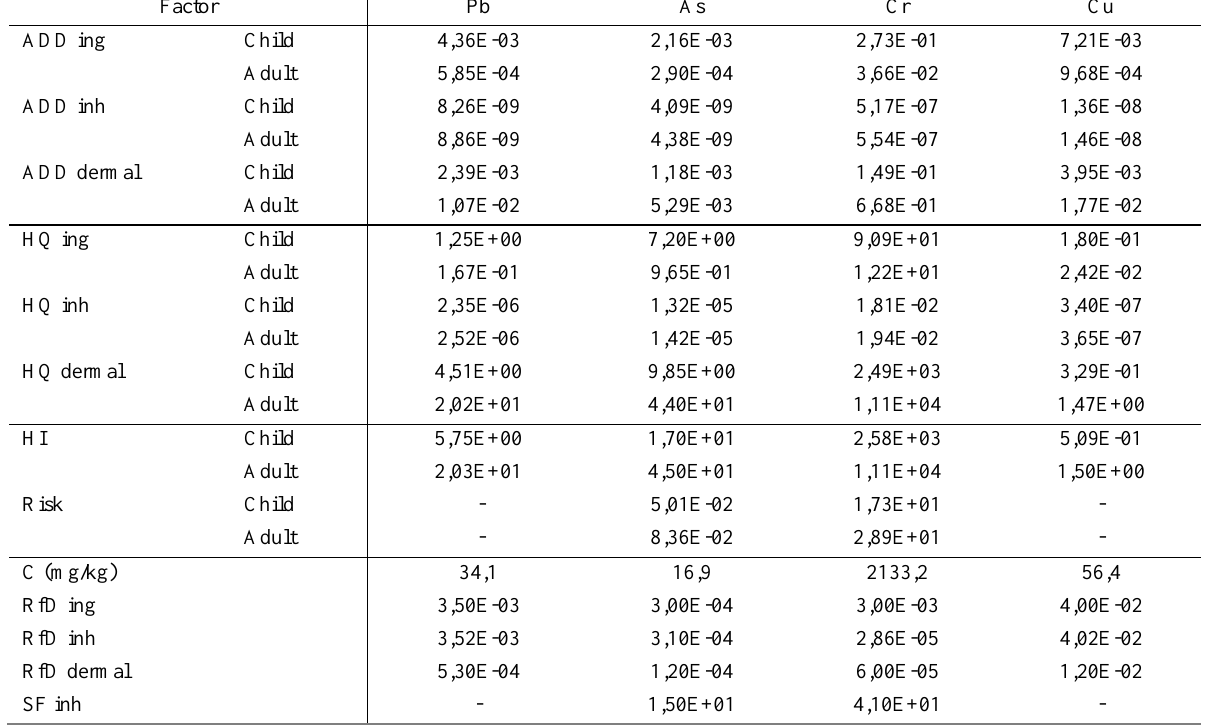
Table 6 . ADDs (mg/kg/day) and health risk for each element and exposure